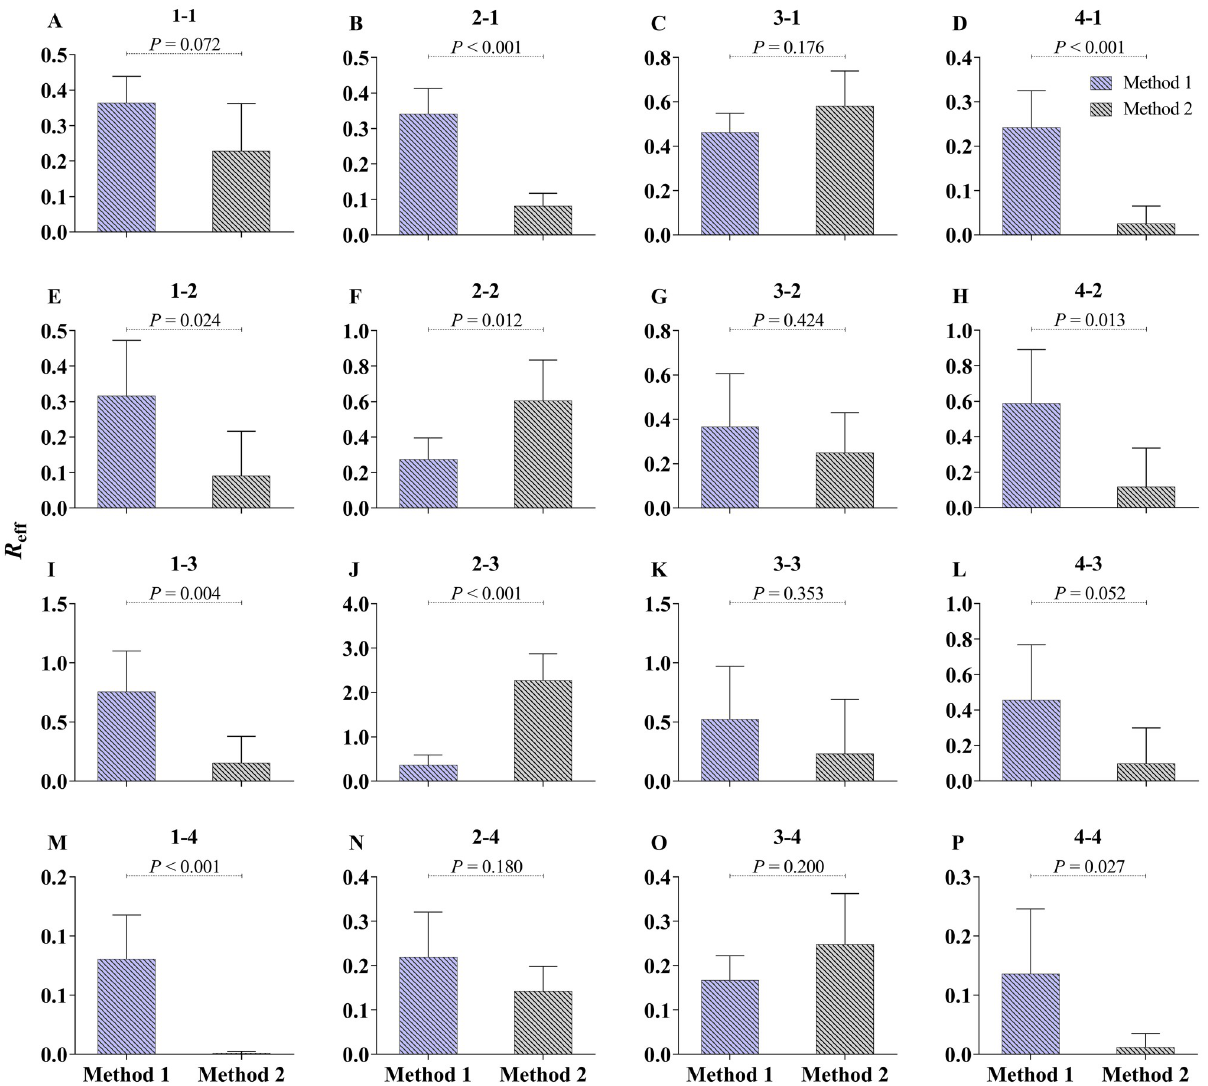
Fig 9. The comparison between method 1 and method 2. Method 1 is setting the initial values of S = total population of each year, E = 0, I = value at the end of the previous parts, A = 0, and R = 0; Method 2 is setting the initial values of S , E , I , A and R are same as the value at the end of the previous parts. The 1 to 4 in each subgraph represent age group � 5 years old, 6–24 years old, 25–59 years old, and � 60 years old,